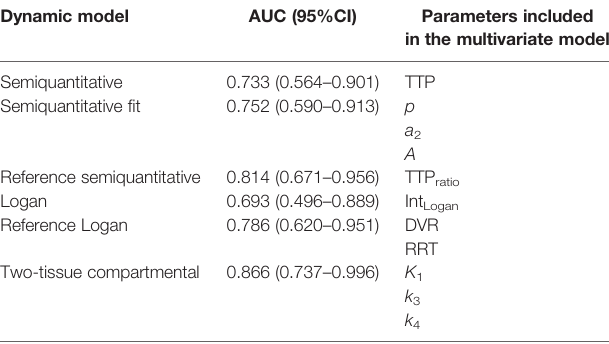
TABLE 1 | Results of the multivariate analyses for predicting isocitrate dehydrogenase (IDH) mutations with different dynamic models. Dynamic